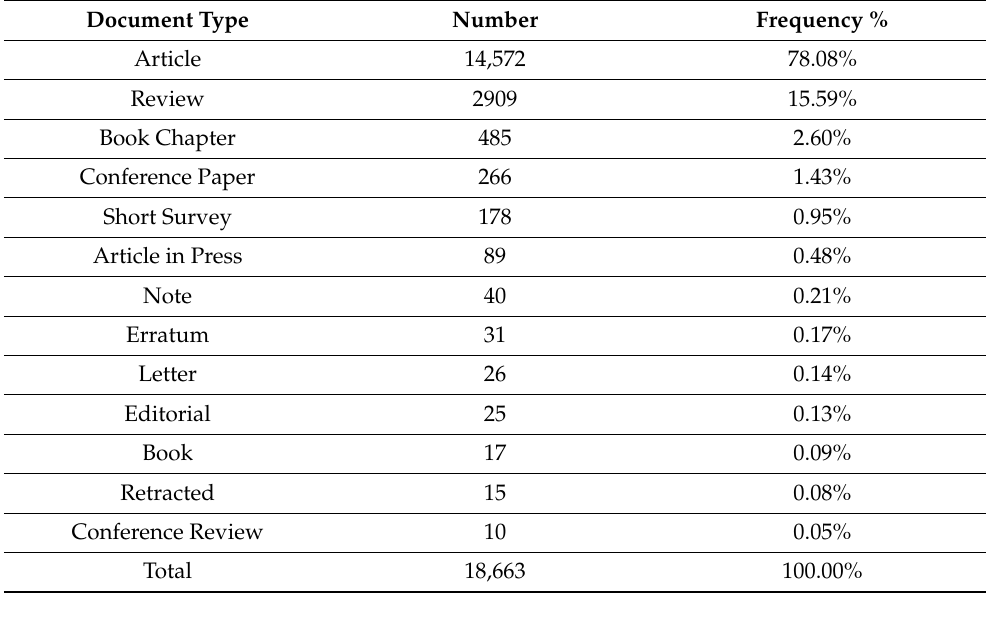
Table 1. The number and frequency of different source types based on bibliometric search for the topic of miRNA research in cancer.